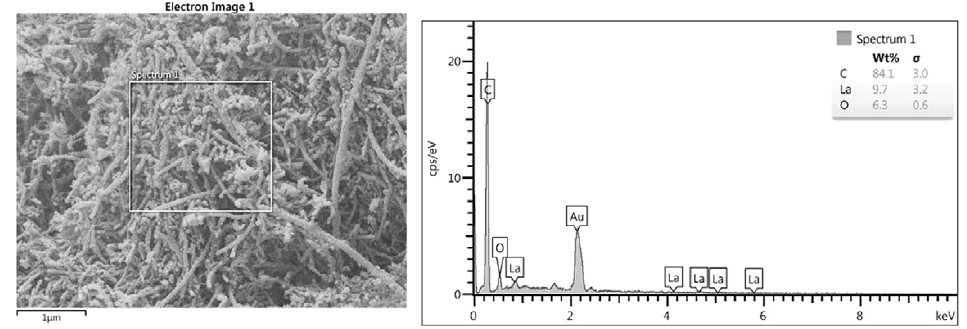
O nanocomposite, (c) Nanotubes outer diameter distribution of (MWCNTs)- 2 3 COOH/La O 2 distribution of (MWCNTs)-COOH/La 2 O 3